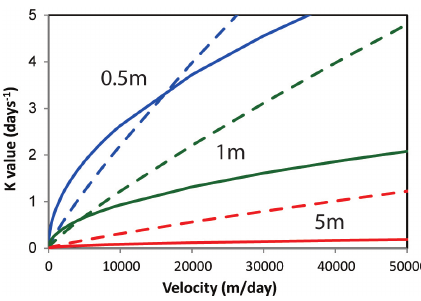
Fig. 10. K values from O’Connor and Dobbins (1958) (solid lines) and Negulescu and Rohanski (1969) (dashed lines) models at 0.5m (blue), 1m (green) and 5m depth (red) with increasing river